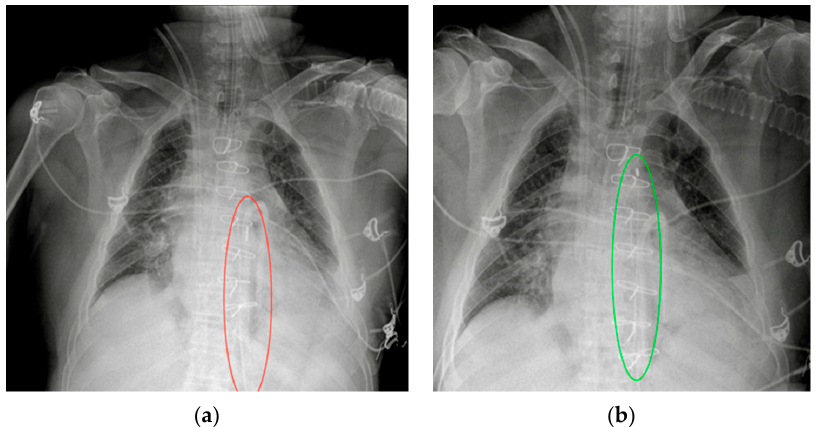
Figure 17. Malpositioned IABP. ( a ) Anteroposterior CXR of a patient with an IAPB placed too distal from the aortic arch: the upper radiopaque mark can be seen at the level of the sixth intercostal space (red circle). ( b ) The same patient after repositioning of the IABP, with the upper mark now just under the aortic arch, in the proximal thoracic descending aorta, at the level of the fourth intercostal space (green circle).